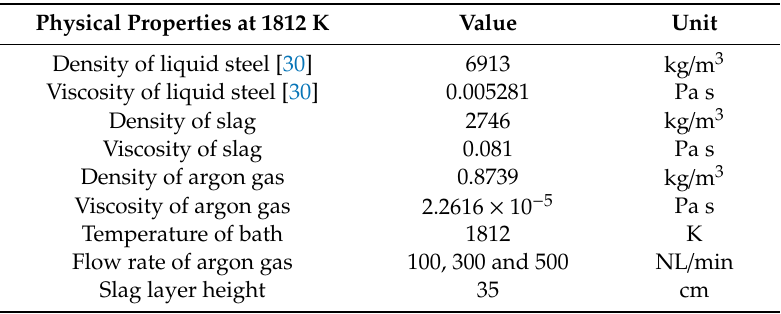
Table 1. Parameters for experiments and simulations.